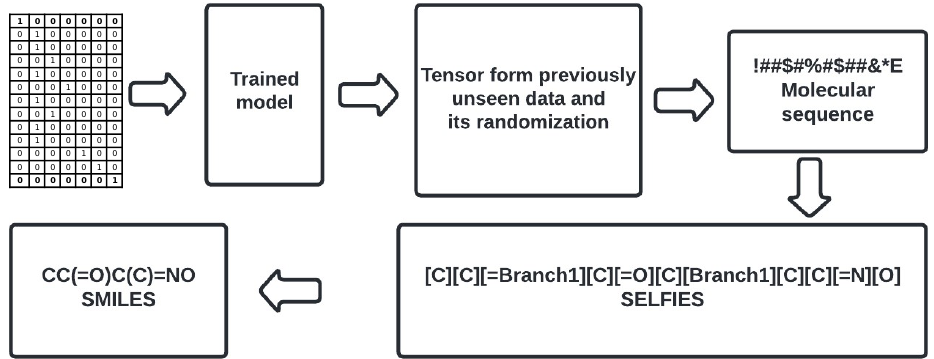
Figure 5. Workflow for data